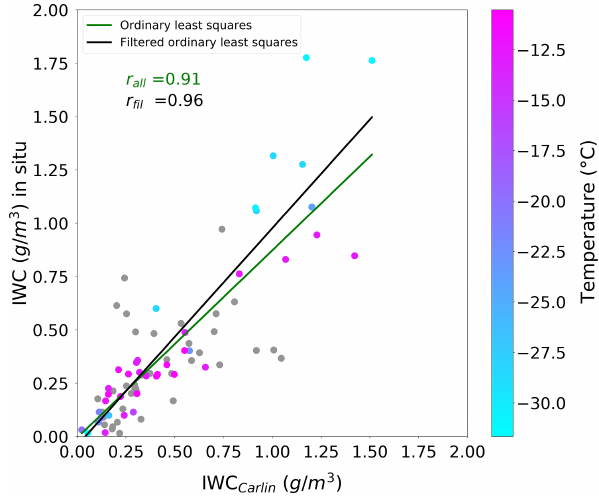
Figure 4. Scatter plots and linear regressions of IWC from OLYM- PEX in situ data vs. IWC Carlin . Temperature-dependent coloring of each data point indicates temperatures colder than or equal to − 10 ◦ C, while the gray dots represent data masked via filter criteria for temperature ( T ≥ − 10 ◦ C) and intersection time ( t ≤ 30s). The r statistics are reported in green for all data points and in black for filtered